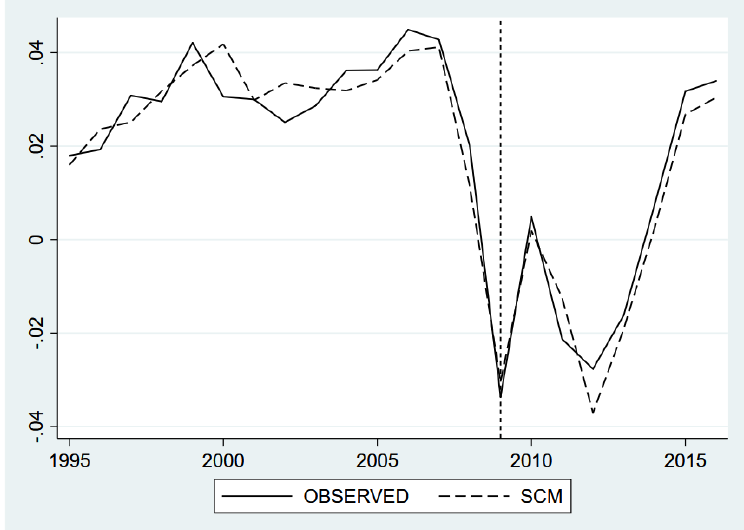
Figure 7 : Observed and SCM GDP growth rates over the period 1995 −